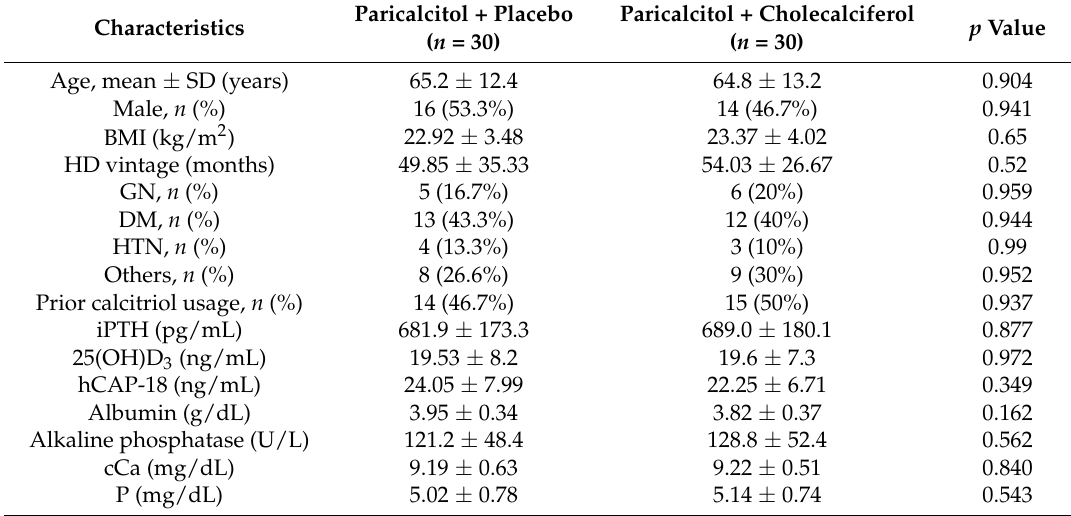
Table 1. Demographic characteristics, diagnosis of renal disease and baseline data in the two groups under study ( n = 30 each).